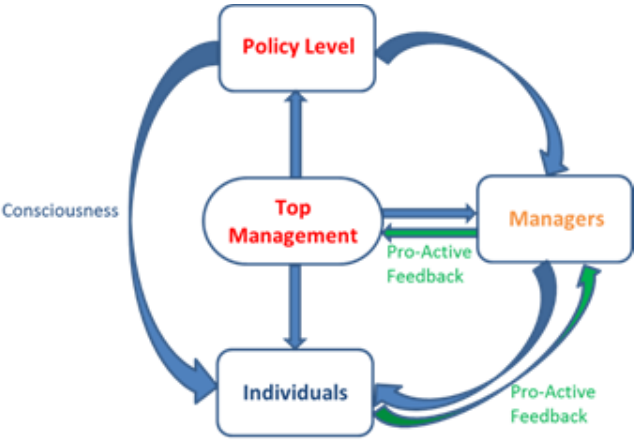
Figure 1. Nuclear Safety Culture (NSC)